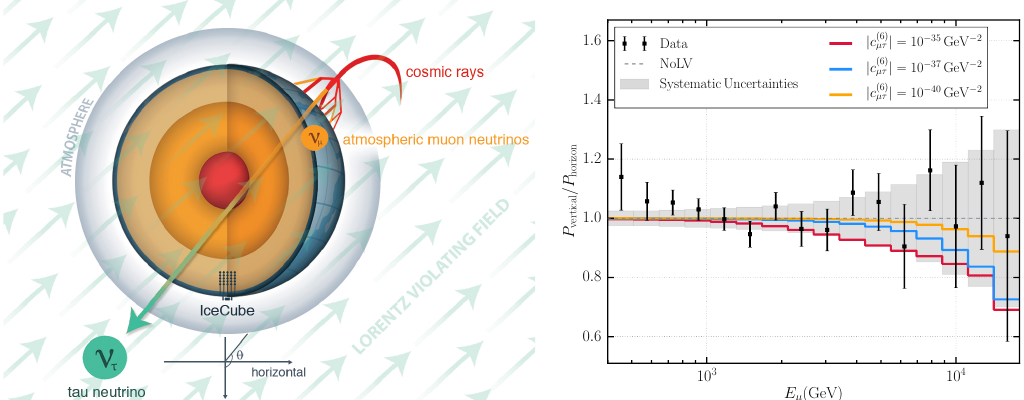
Figure 2. Left, artistic illustration of the search for LV with atmospheric neutrino oscillations. Atmospheric neutrinos are produced in the upper atmosphere, and their flavors may be converted due to couplings between neutrinos and LV background fields as they propagate. The effects induced by the new physics are negligible if neutrinos travel a short distance, namely for neutrinos entering the IceCube volume from the horizontal direction. However, neutrinos are produced near the northern sky travel a long distance before they reach IceCube, and they are significantly more impacted by interactions with the LV background fields. Right, expected atmospheric neutrino oscillation probability ratio with function of energy due to LV. Here, the vertical axis is the double ratio of oscillation probability for neutrinos, from the vertical to horizontal direction. No LV is adjusted to the unity in this figure. Nonzero LV modifies this ratio, and the larger deviations ( 6 ) c happen with the larger LV couplings. The figure shows the sensitivity to µτ | , one of dimension-six operators, which | parameterize LV and this analysis is sensitive with. Figures are adapted from